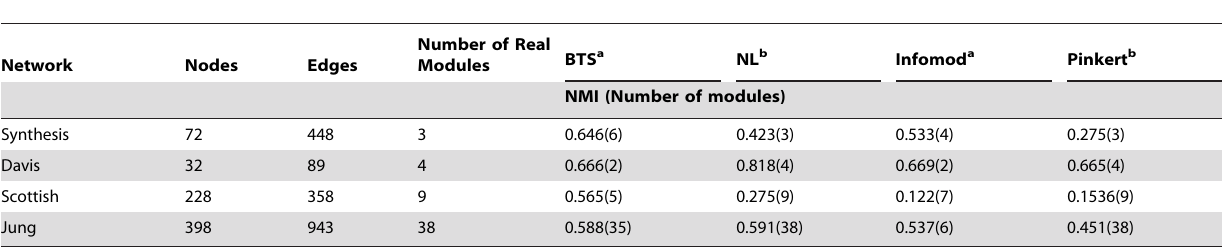
Table 1. Performance comparison of four methods on 4